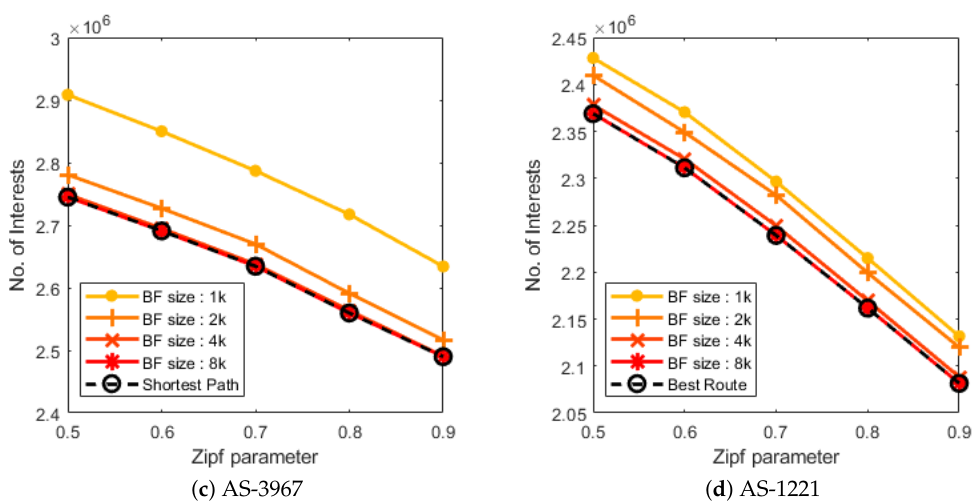
Figure 7. The number of Interest packets under the various sizes of Bloom filters. As the size of the Bloom filters gets larger, the number of multicasts decreases.